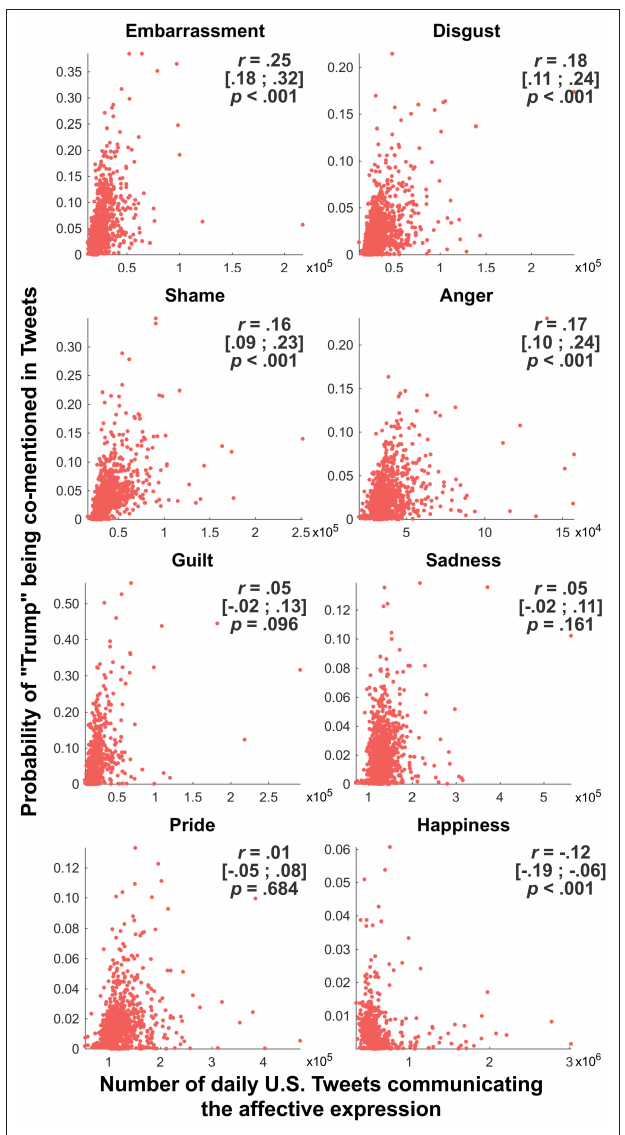
FIGURE 2 | Association of “Trump” with the daily communication of emotional expression on Twitter in the U.S between June 3, 2015 and December 31, 2017. Each plot depicts the daily volume of Tweets containing the emotional expression (e.g., for disgust all Tweets containing either “disgust,” “disgusting,” “disgusted,” or “disgusts”) on the x-axis and the probability that “Trump” was co-mentioned in the Tweets with the emotional expression of that day on the y-axis. Correlation coefficients depict Spearman’s rho after controlling for linear autoregressive effects (AR2) in each of the two timeseries together with their 95% confidence intervals (in brackets below) and p -values (two-sided). Strongest associations can be found with emotional expressions with negative valence such as embarrassment but also disgust, shame, and